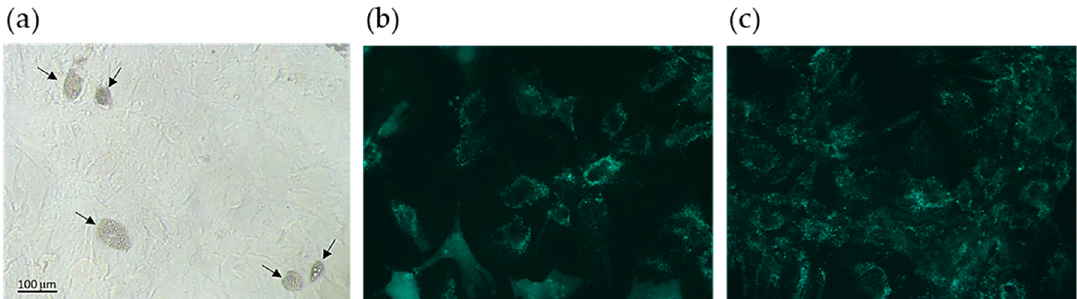
Figure 10. Adipo-differentiated hMSCs: ( a ) as observed under light microscopy: fat vesicles are pointed by arrows; ( b , c ) Live cell fluorescent staining (Calcein AM) of adipo-differentiated hMSCs placed together with ( b ) pullulan and ( c ) pullulan/CLA beauty mask samples for 5 days. Original magnification 100×. [CLA stands for CN-NL-GA].